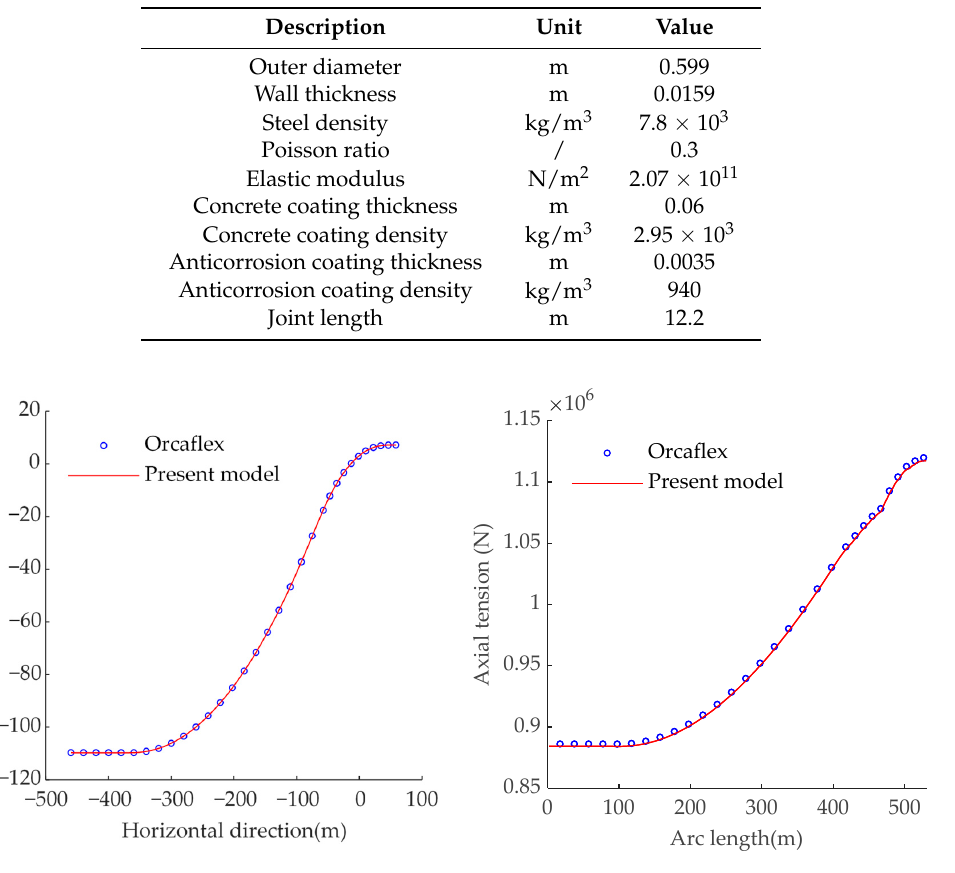
Table 3. Parameters for the 22 (cid:48)(cid:48) gas pipeline.